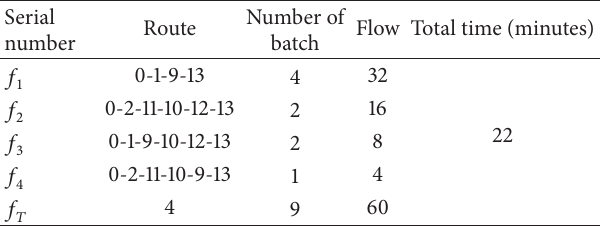
Table 6: Optimal routes of one-to-one evacuation on